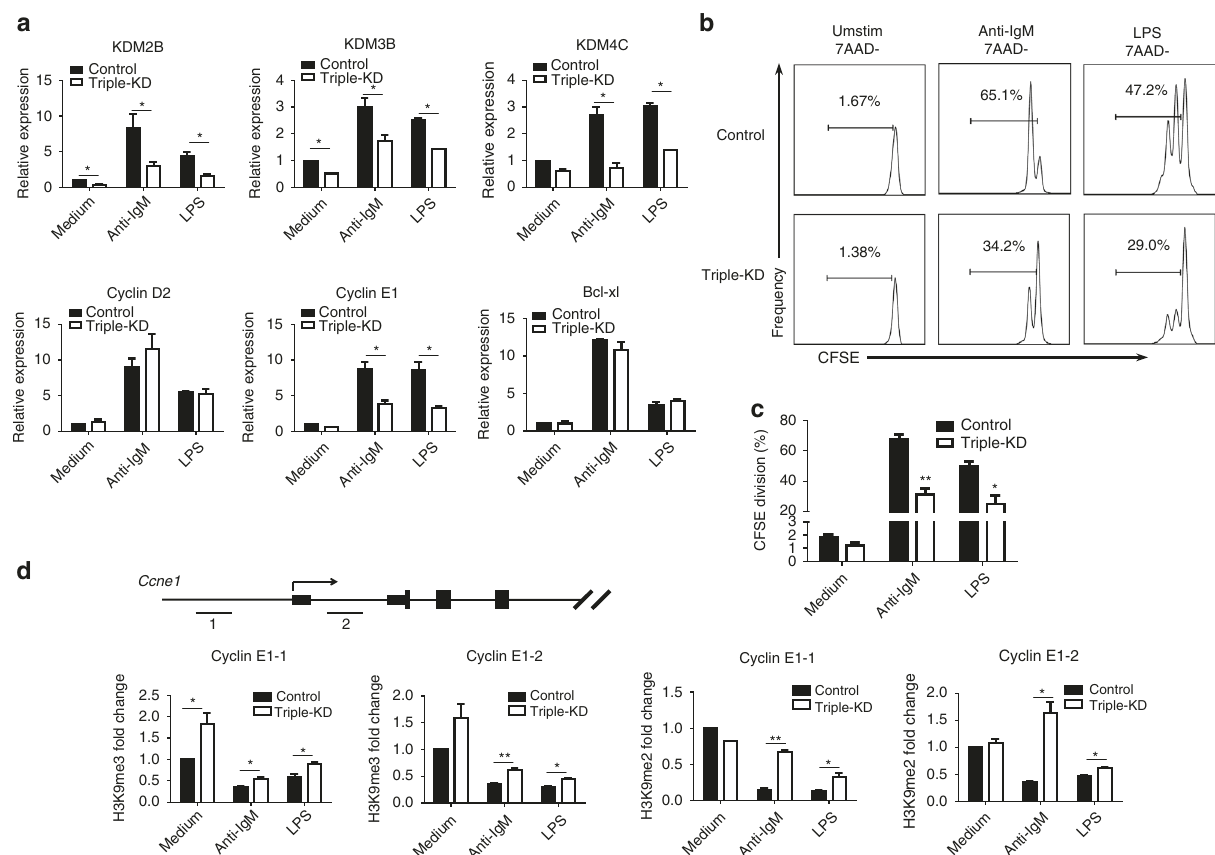
Fig. 8 Triple-KD of three JmjC-demethylases reduces H3K9me3/2 demethylation and inhibits B-cell proliferation. shRNA lentiviruses targeting KDM2B, KDM3B, and KDM4C were mixed and used to infect splenic B cells. a The expression of cyclin E1, cyclin D2, Bcl-xL, and the three demethylases was analyzed by qRT-PCR 48 h after anti-IgM and LPS stimulation. b CFSE-labeled splenic B cells were infected with the shRNA lentivirus mixture, and cell proliferation was analyzed by fl ow cytometry at 72 h after anti-IgM and LPS stimulation. c Statistics for the percentage of B cells that underwent division following infection with the shRNA lentivirus mixture or control. d Changes in H3K9me2 at the cyclin E1 promoter were analyzed by ChIP-qPCR. All graphs with error bars indicate the mean ± SEM, * P < 0.05, ** P < 0.01, Student ’ s t